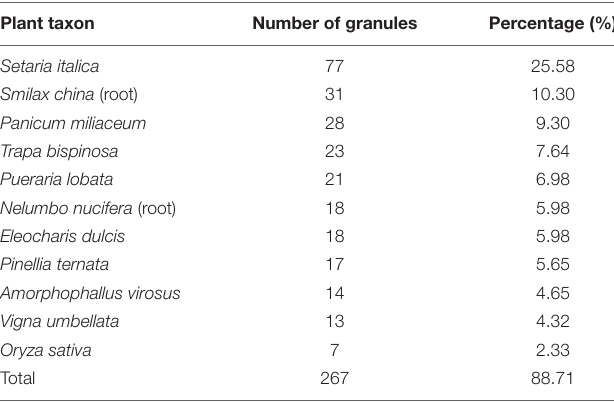
TABLE 4 | Prediction result in Liangwangcheng starch granule